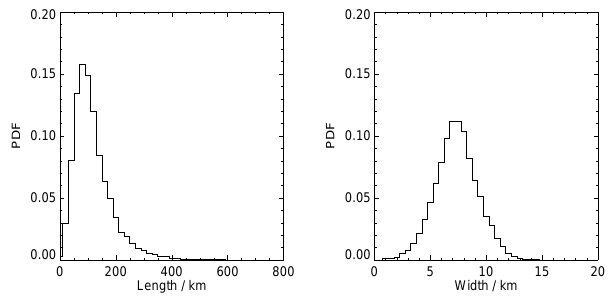
Figure 5. Probability density function of the effective length and width of the contrails studied.